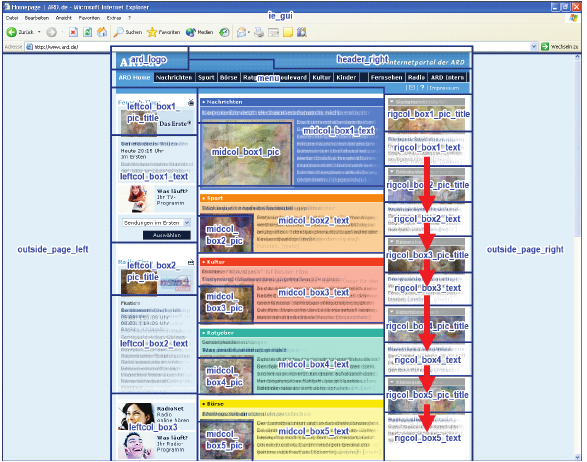
Figure 7. Long ARD pattern involving 7 ROIs, occurring in 5 out of 10 presentations, initially in presentation 3 (participant 8); blurred elements varied from presentation to presentation